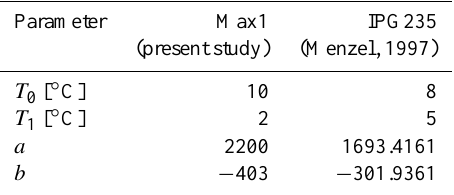
Table 1. Parameters of the modified approach for estimating leaf unfolding (LU) according to Cannell and Smith (1983), which is used in WaSim. Estimated day of years (DOY) of LU for Reiffen- hausen (2012 and 2013) are used to calibrate the Max1 parameters T 0 , T 1 , a and b , i.e. threshold temperature for chilling units and forcing units and regression parameters of two poplars, i.e. Max1 and IPG235 ( Populus tremula ), respectively. Additionally, the pa- rameter set for IPG235 according to (Menzel, 1997, Appendix A7) is